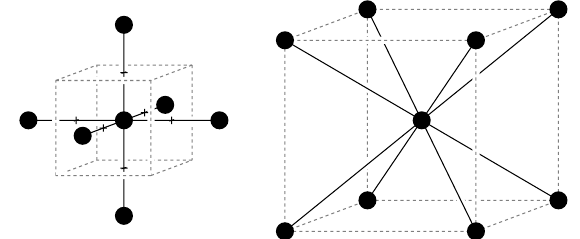
Figure 1. Unit cell of the six chain model ( left ) and eight chain model ( right ). The nodes represent reticulation points and the bold lines correspond to the polymer segments. These systems are labelled A.6 and A.8 in the following and correspond, respectively, to a simple cubic and to a body centered cubic lattice. All nodes are equivalent and connected to all their nearest